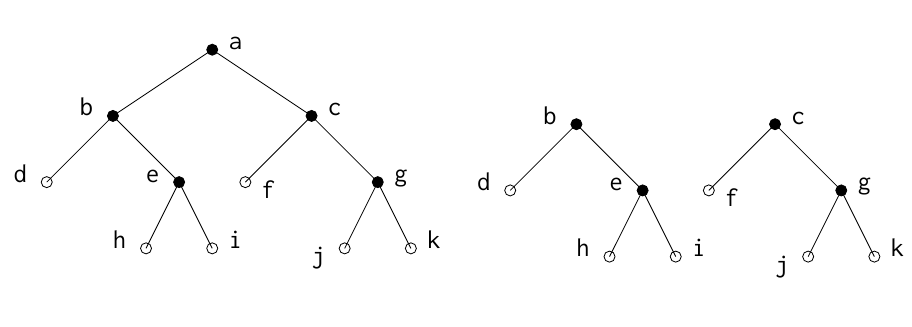
Figure 2. { a } is a df